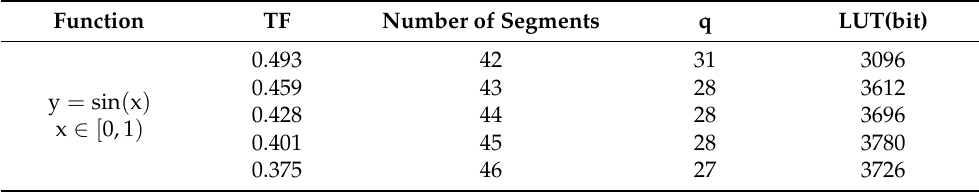
Table 2. Impact of